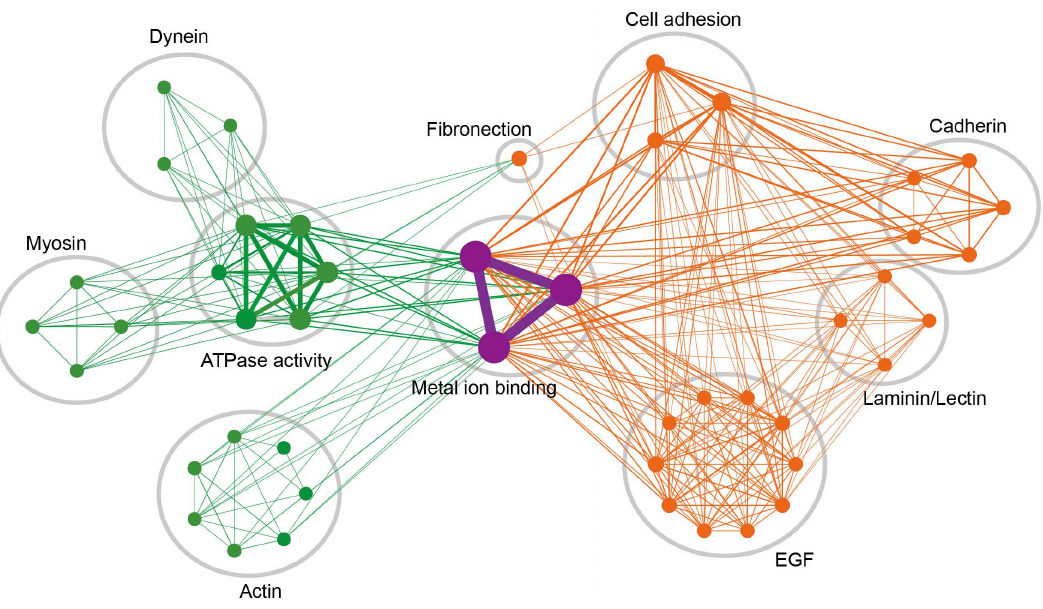
Figure 2. Analysis of gene function enrichment and construction of functional network. Gene functions significantly enriched in genetic variants from implant clustering failure patients are visualized as a functional cluster network. Nodes represent enriched clusters of gene functions in cell morphology (green), cell adhesion (orange), and regulation of metal ion concentration (purple). Size of nodes shows the number of genetic variants in each functional group. Edge weight is proportional to the number of shared genes. Clusters of functionally related nodes were manually circled and labeled.